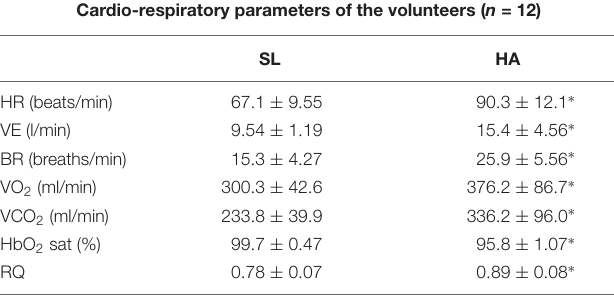
TABLE 2 | Cardio-respiratory parameters at SL (Antofagasta) and HA (Caspana, 3,270 m a.s.l.). Cardio-respiratory parameters of the volunteers ( n = 12)